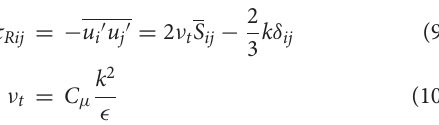
Frontiers in Energy Research |